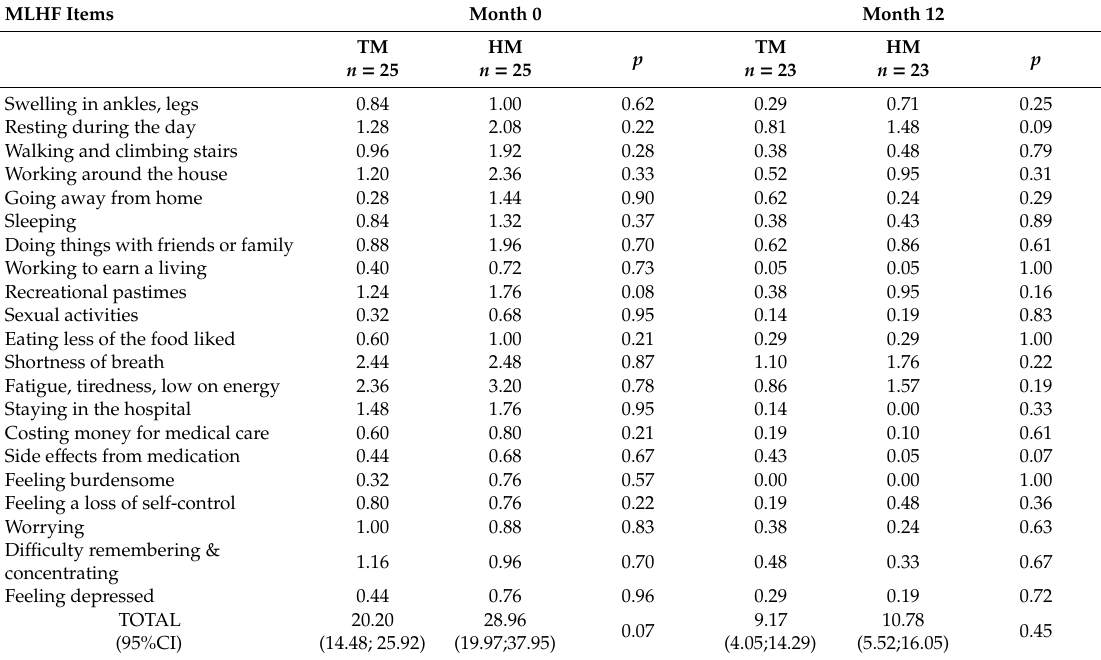
Table 2. Minnesota Living with Heart Failure questionnaire (MLHF)